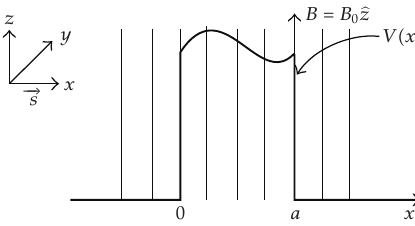
Figure 3: Orientations of spin amd magnetic field for the case of the “Larmor